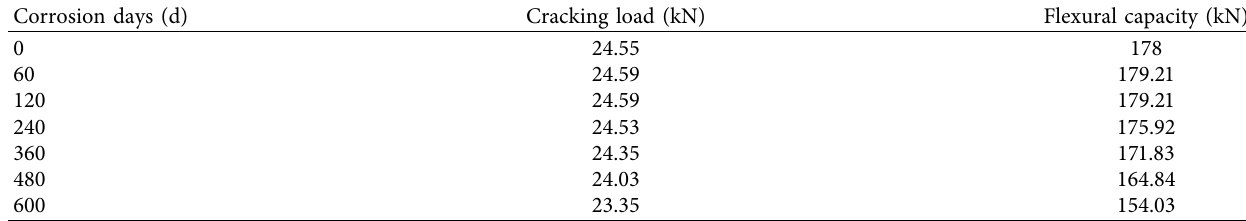
Table 4: Cracking load and flexural capacity corresponding to different corrosion days.